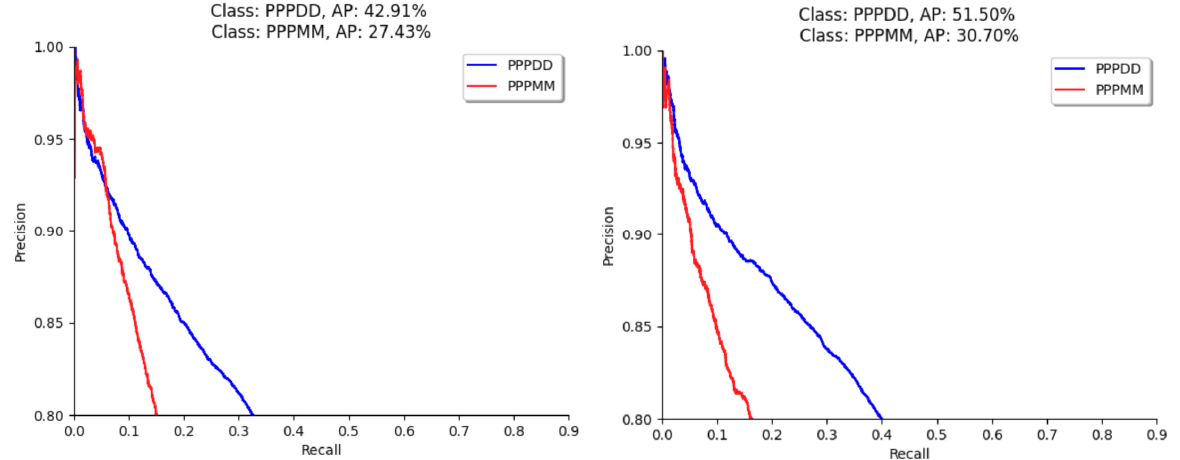
Figure 13. The Precision/Recall curve obtained from the results of the object detection models on the in-situ images. Left : EfficientDet, and Right : YOLOv5. The classes are the same as Figure 8. In Figure 14, The normalized and non-normalized confusion matrices of the weed dataset were computed. It can be seen that, the false positive rate (FPR) of the actual monocot weeds that were wrongly detected as dicot were 3% and 1% for EfficientDet and YOLOv5 models, respectively; and 1% and 1% for the dicot weeds miss-classified as monocot. This is due to the fact that the extracted features from dicot are robust and make both networks capable of distinguishing dicot from monocot clearly. In terms of the FNR and FPR for both classes, YOLOv5 achieved better performance as it had a smaller number